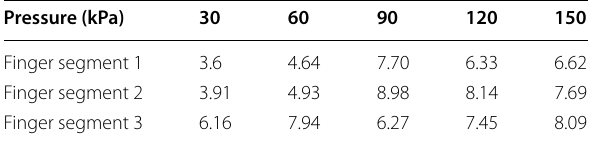
Table 2 Response time of two grippers